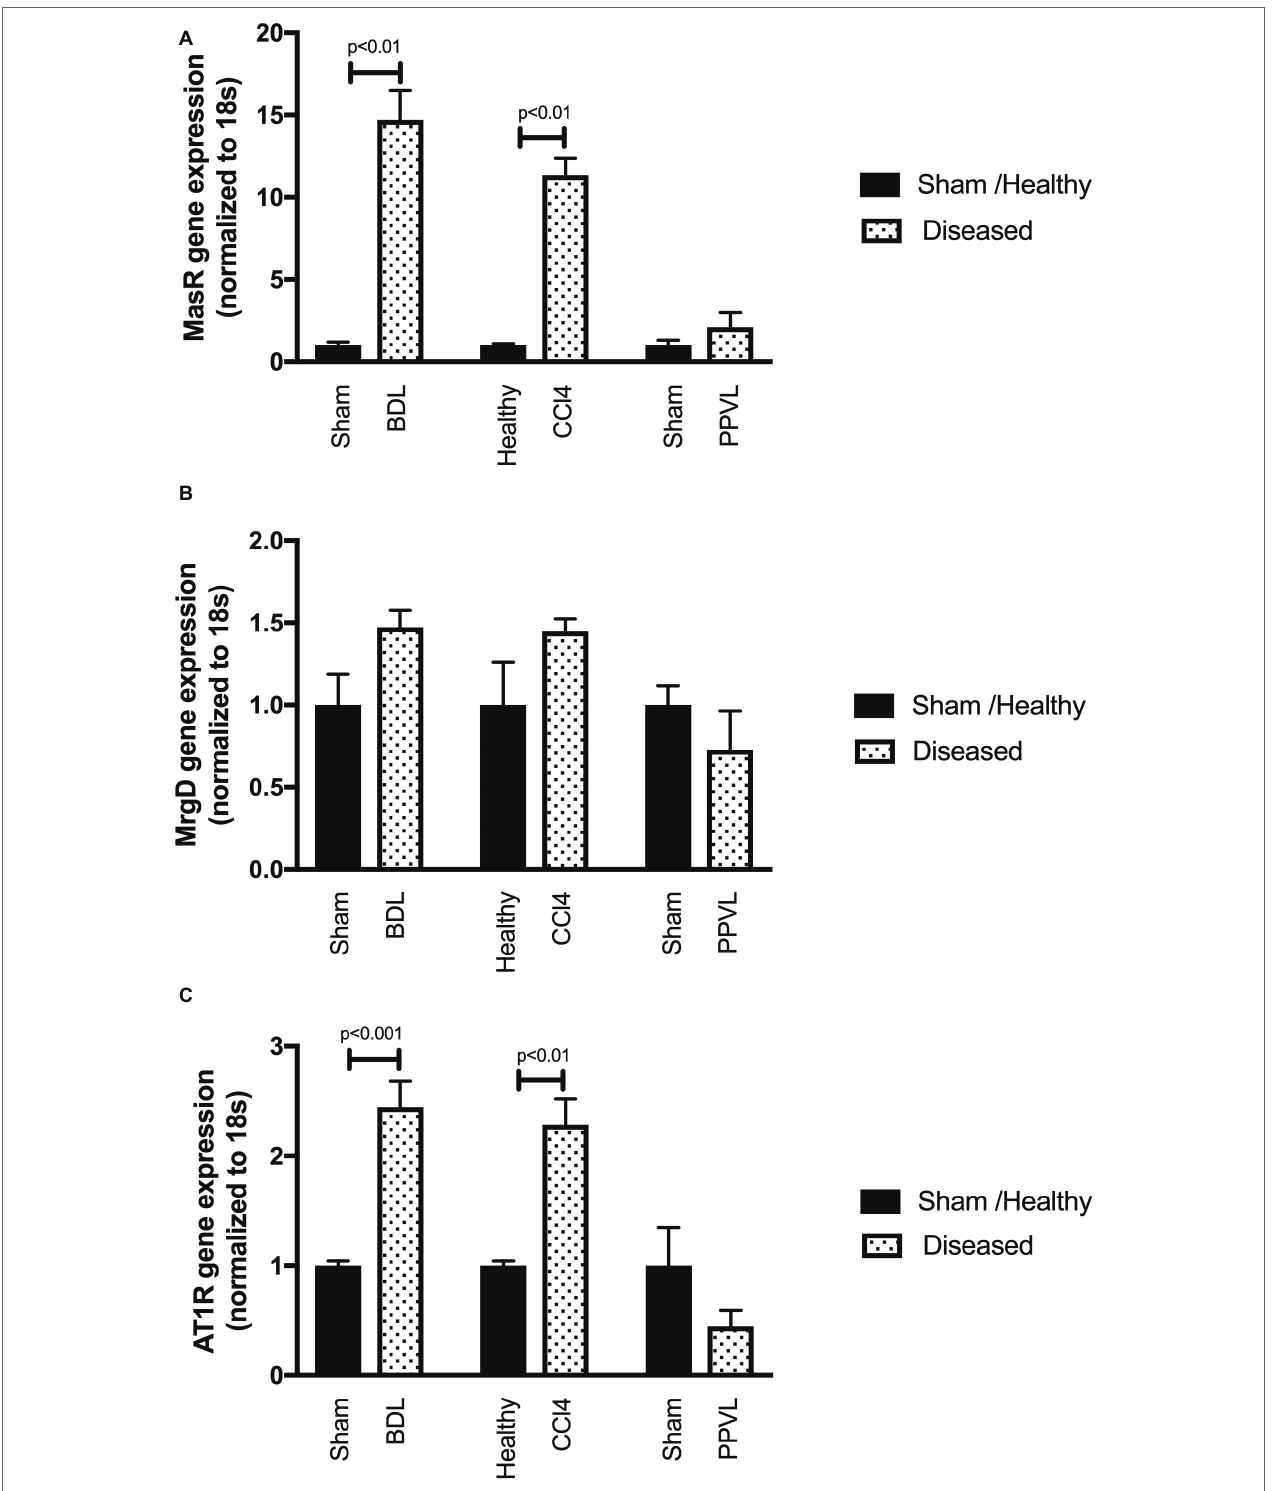
FIGURE 9 | Receptor gene expression of MasR (A) , MrgD (B) , and AT1R (C) analyzed by qPCR in the livers of the CCl 4 , BDL, and PPVL rats compared with sham-operated and healthy control rats. Data have been normalized to endogenous control gene 18S, and healthy control group was given an arbitrary value of 1. Each time point represents the mean ± SEM profile from six to seven rats per treatment